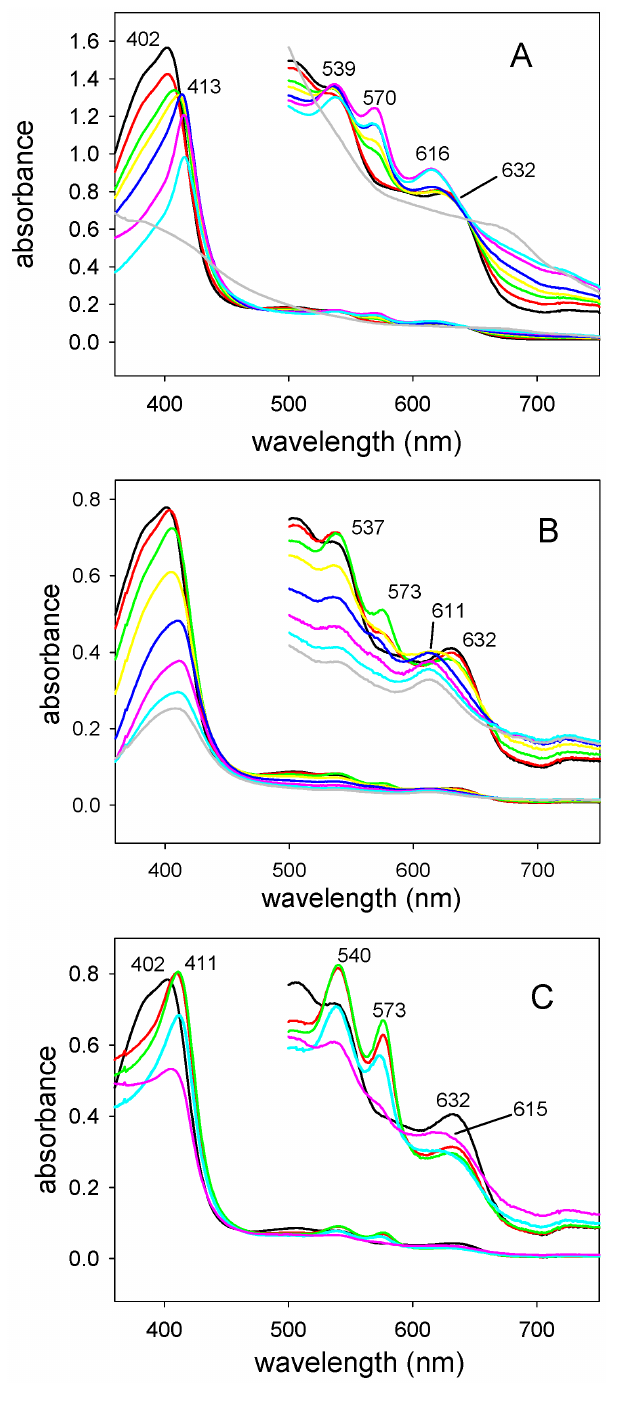
Figure 6. Absorbance spectra showing conversion of the BBPLo-heme complex to products. (a) Treatment of the complex with sodium ascorbate (1.4 mM) at 37 u C. Spectra were recorded periodically for 3.5 hr and then after 36 hr. Labeled peaks indicate the formation of an oxyferrous complex and its conversion to a species having an absorbance maximum at 615 nm. Timepoints: Time=0, black; 20 min, red; 40 min green; 65 min, yellow; 125 min blue; 215 min, pink; 18 hr, cyan; 48 hr, gray. (b) Reduction of the complex with an NADP + -ferredoxin reductase-ferredoxin system in the absence of catalase. Timepoints: Time=0, black; 1 min, red; 5 min, green; 15 min, yellow; 30 min, blue; 60 min, pink; 90 min, cyan; 120 min, gray. The components of the reducing system were added to both the